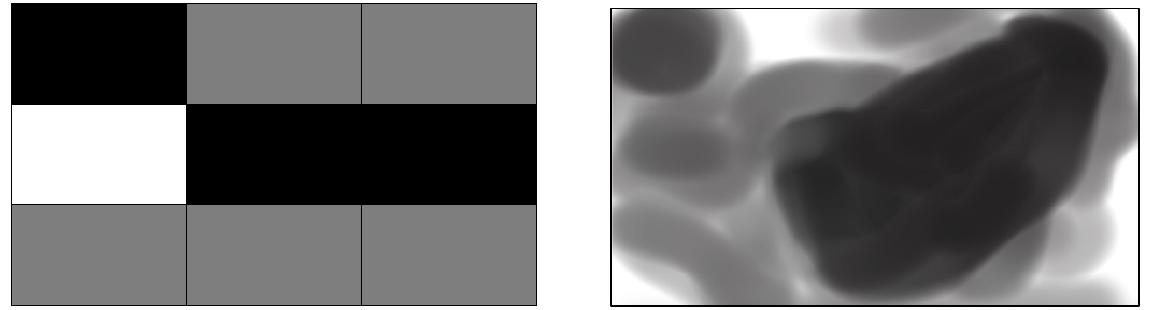
Figure 3. ( Left ) Example of how a landscape may look using one of the current individual species susceptibility models (Table 3). Each individual stand (16 to 40 ha) would be assessed and rated individually using the indices found in Table 1. Treatments would likely focus on the high-risk stands (black). ( Right ) While the stand is often the administrative or management unit (unit to be thinned or harvested), forests and bark beetles occur across a landscape. By assessing susceptibility at the landscape level, treatments can focus on resilience and can better take into account bark beetle life cycle dynamics and variability of host substrate.